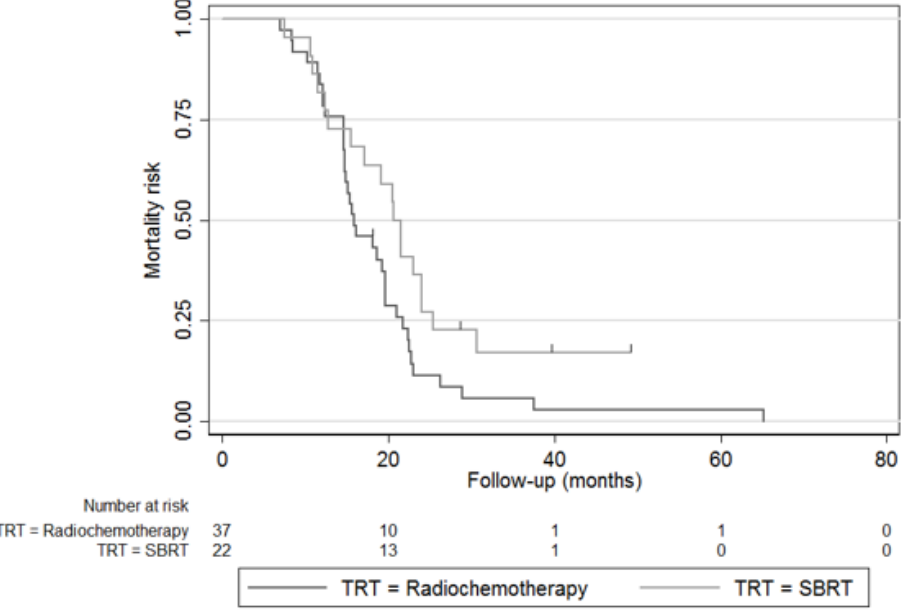
Figure 2. Kaplan–Meier plot of overall survival of the iHD-SBRT and CRT cohort for patients without oncological resection only ( n = 59).